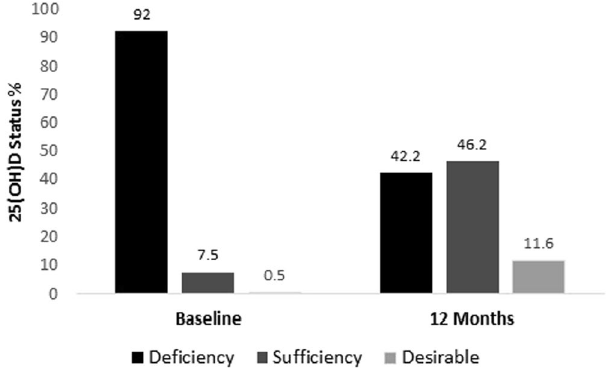
Figure 1. Comparison of the vitamin D status before and after 12 months of vitamin D supplementation. Deficiency: Serum 25(OH)D level < 50 nmol/L. Sufficiency: Serum 25(OH)D level ≥ 50 nmol/L. Desirable: Serum 25(OH)D level > 75 nmol/L.